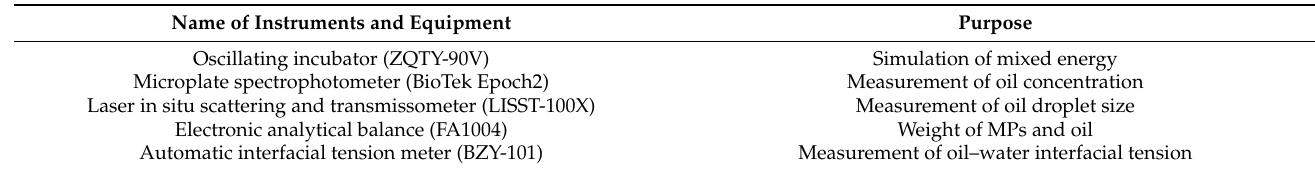
Table 1. Summary of the experimental instruments and equipment. Name of Instruments and Equipment